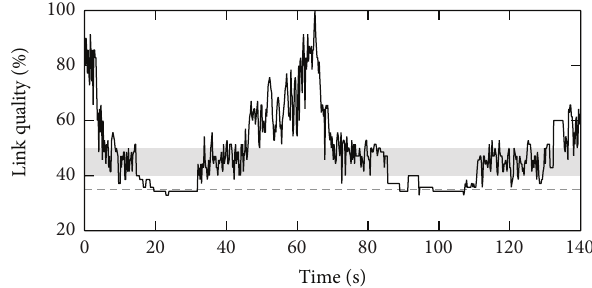
Figure 8: Measured link quality over 140 seconds. Packets got lost when the link quality was below the dashed line. The protocol stack is adapted when the graph crosses the gray bar